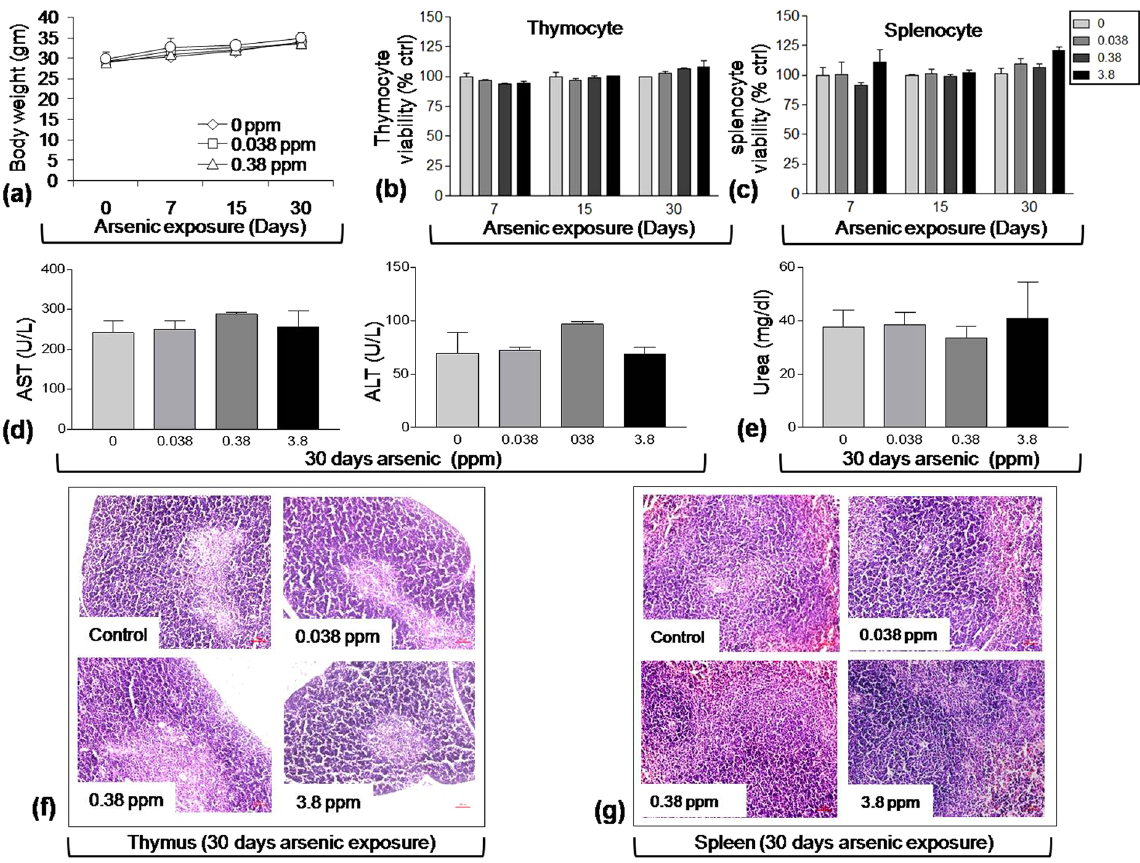
Figure 8. Effect of arsenic exposure on general parameters. Following arsenic exposure mice body weight was recorded weekly. (a) Line graph represents the changes in body weight. Values presented as mean ± S.E at each time point (n = 5–8 per group). (b) Thymocytes and (c) splenocytes (0.1 × 10 6 cells/200 µ l/well) isolated from mice treated with arsenic (0.00, 0.038, 0.38 and 3.8 ppm) orally for 7, 15 and 30 days were cultured at 37 °C in 5% CO (d) AST, ALT and (e) urea expressed as mean ± S.E. (n = 3 per group). Representative micrographs of histo- 30 day exposed